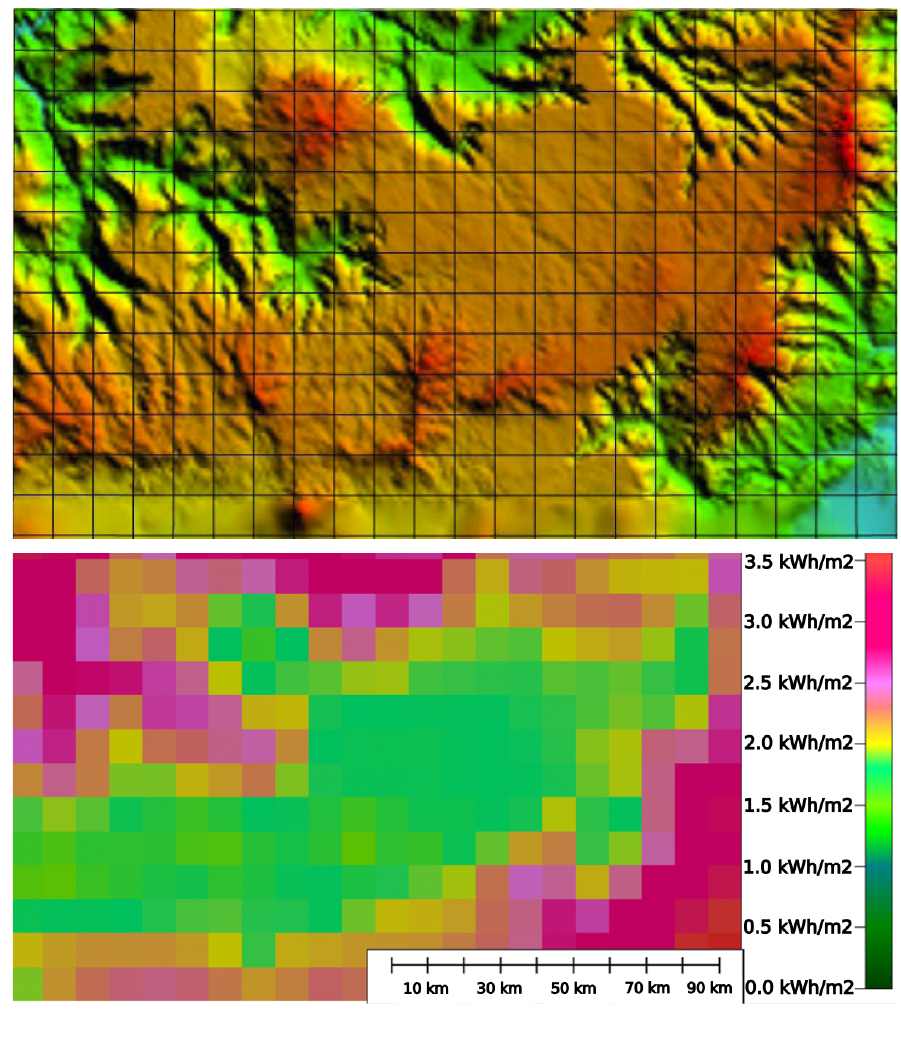
Figure 1. High-resolution elevation map (above) and low-resolution daily solar radiation map with 100 km 2 cell size (below) of Amhara region, North Shewa